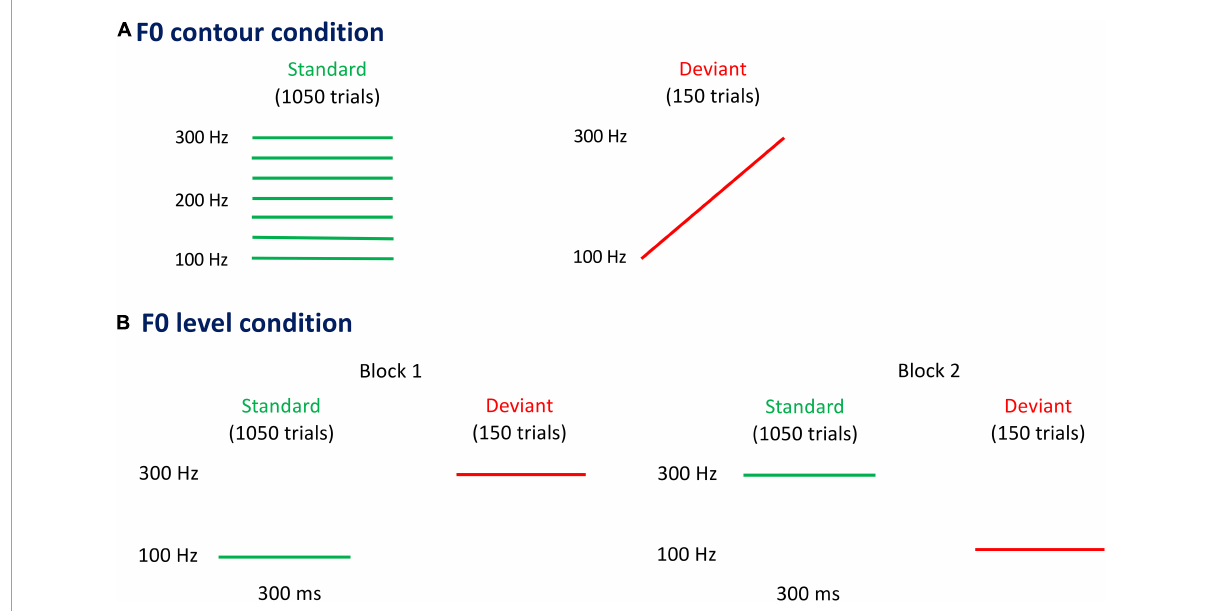
FIGURE1 Pitch contours carried by vowel/a/in fundamental frequency (F0) contour condition (A) and F0 level condition (B) . In the F0 contour condition, seven flat F0 contours (left panel) carried by vowel/a/are used as standard stimuli, each of which presents with 12.5% probability (i.e., 150 trials). The rising F0 contour (right panel) carried by vowel/a/is used as deviant stimulus, being presented with 12.5% probability (i.e., 150 trials). There are two blocks in the F0 level condition, in which the two flat F0 contours carried by vowel/a/are used as standard stimulus in one block and as deviant stimulus in the other block. The probability of standard and deviant stimuli in each block is 87.5% (i.e., 1,050 trials) and 12.5% (i.e., 150 trials), respectively.